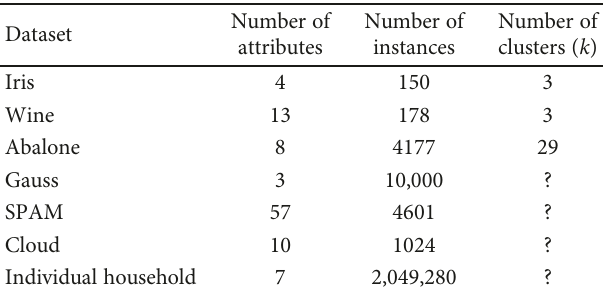
Table 2: Description of seven